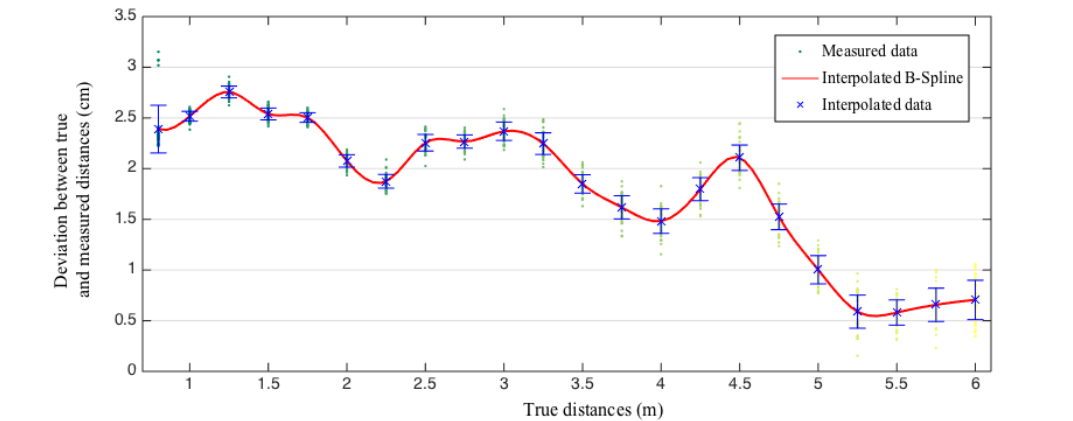
Figure 11. Deviations of measured distances with respect to true distances (without correction of offset distance between fixing crew and